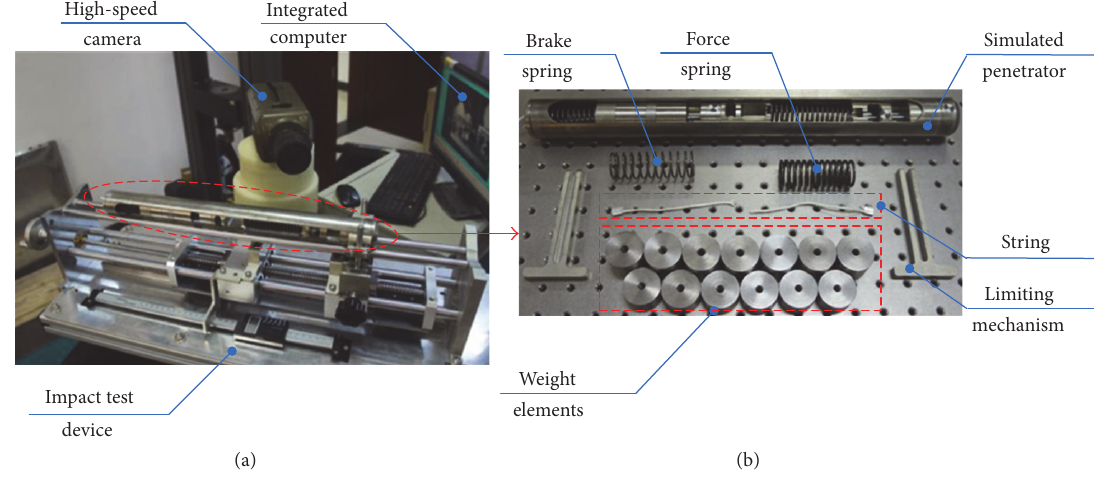
Figure 4: The impact test device scheme: (a) experimental equipment of the impact test; (b) the components of simulated